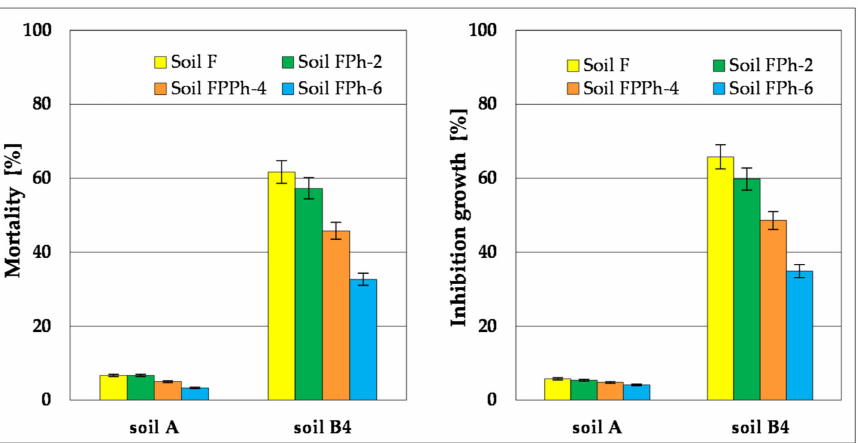
Figure 9. Comparison of death rate and growth inhibition ( Heterocypris incongruens ) during phytore- mediation carried out with Melilotus officinalis , enhanced by fertilization of soils A and B4 (repetitions number = 3, p < 0.05).